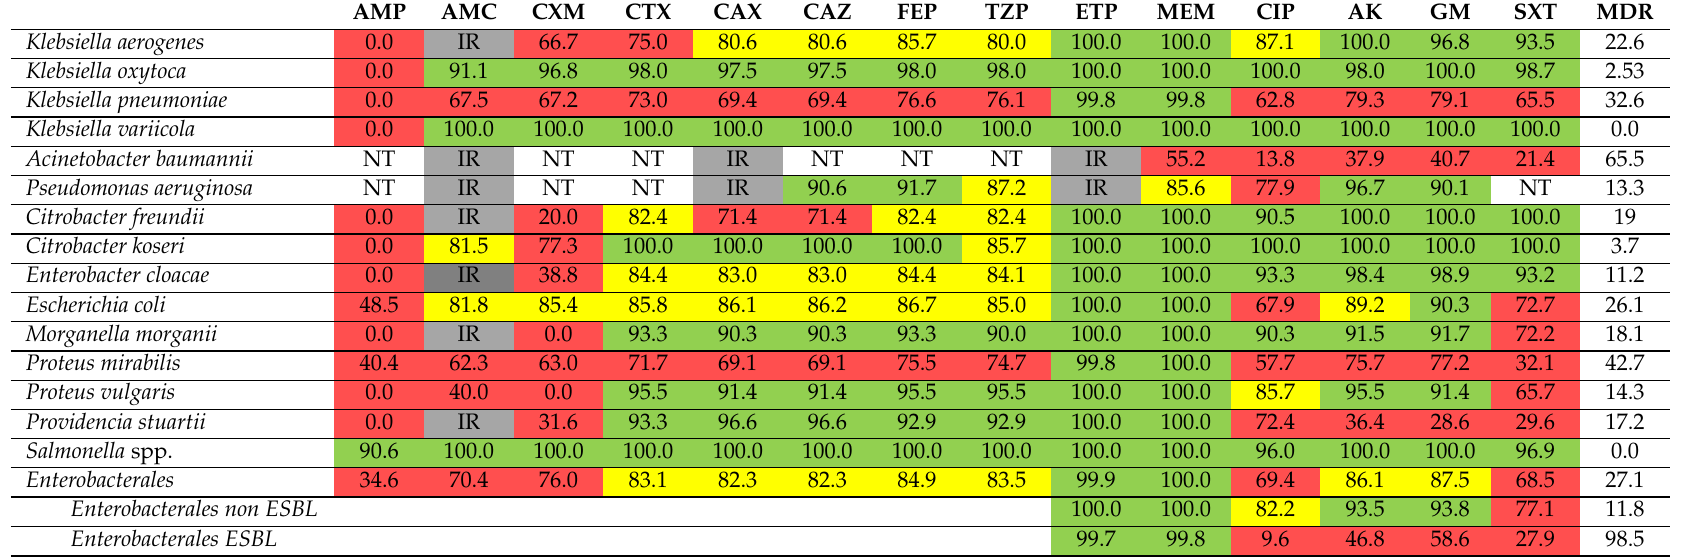
Table 5. Rates of susceptibility and multi-drug resistance for Gram-negative ESKAPE